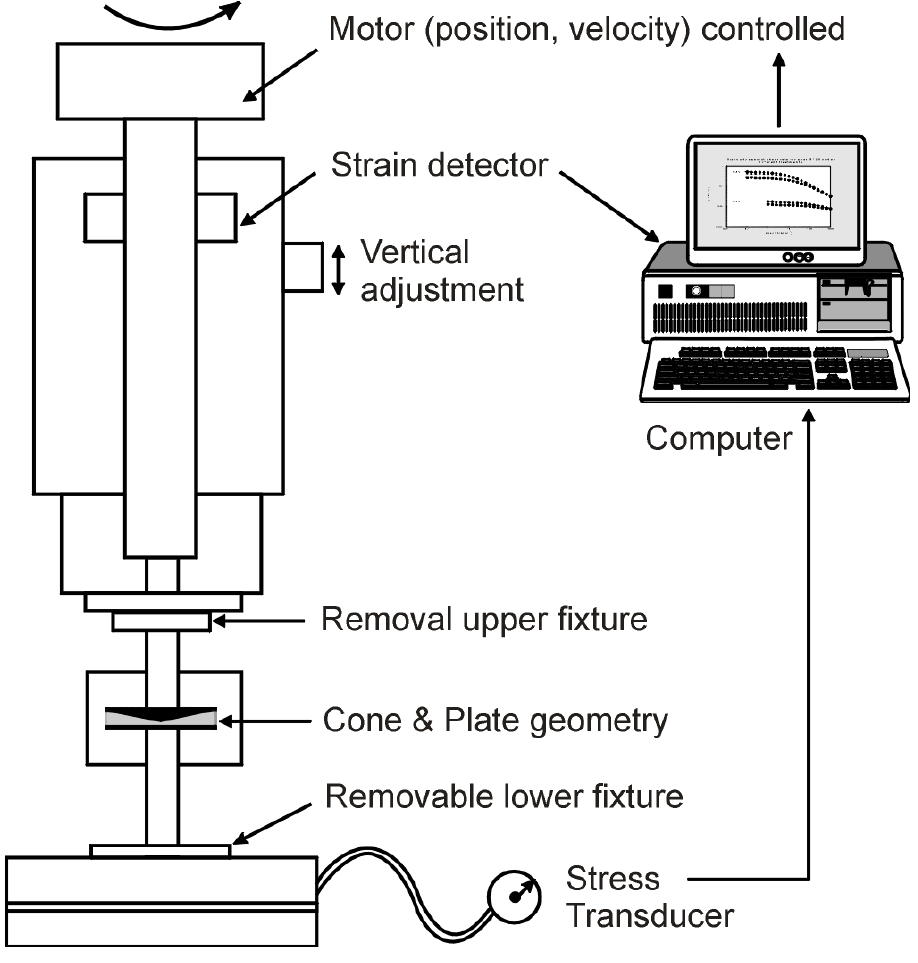
FIGURE 4. Schematic representation of a modern controlled strain